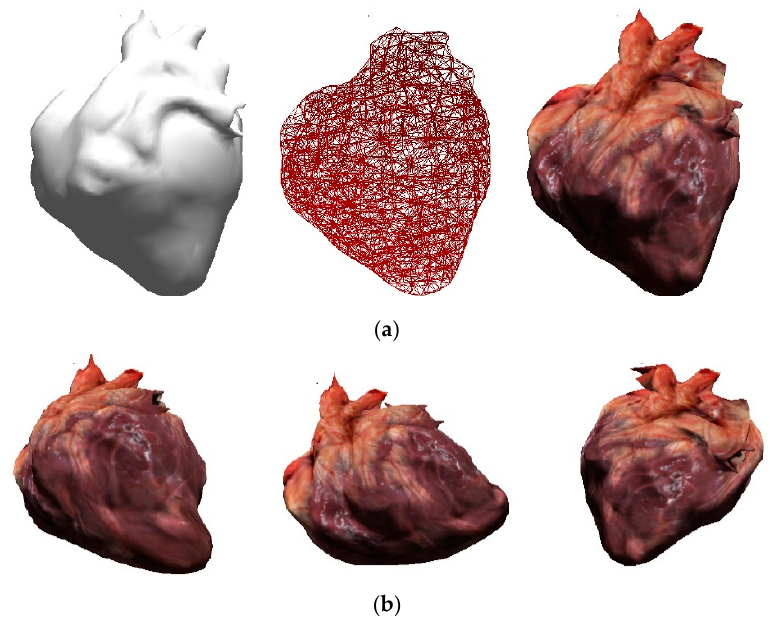
Figure 4. Heart model: ( a ) Geometry, FE mesh, and texture; ( b ) screenshots from an interactive simulation [72].